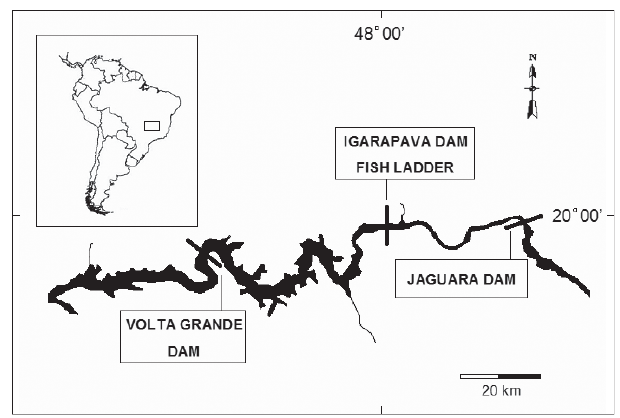
Fig. 1. Study area; location of Volta Grande, Igarapava and Jaguara reservoirs in the Grande River, Southeast